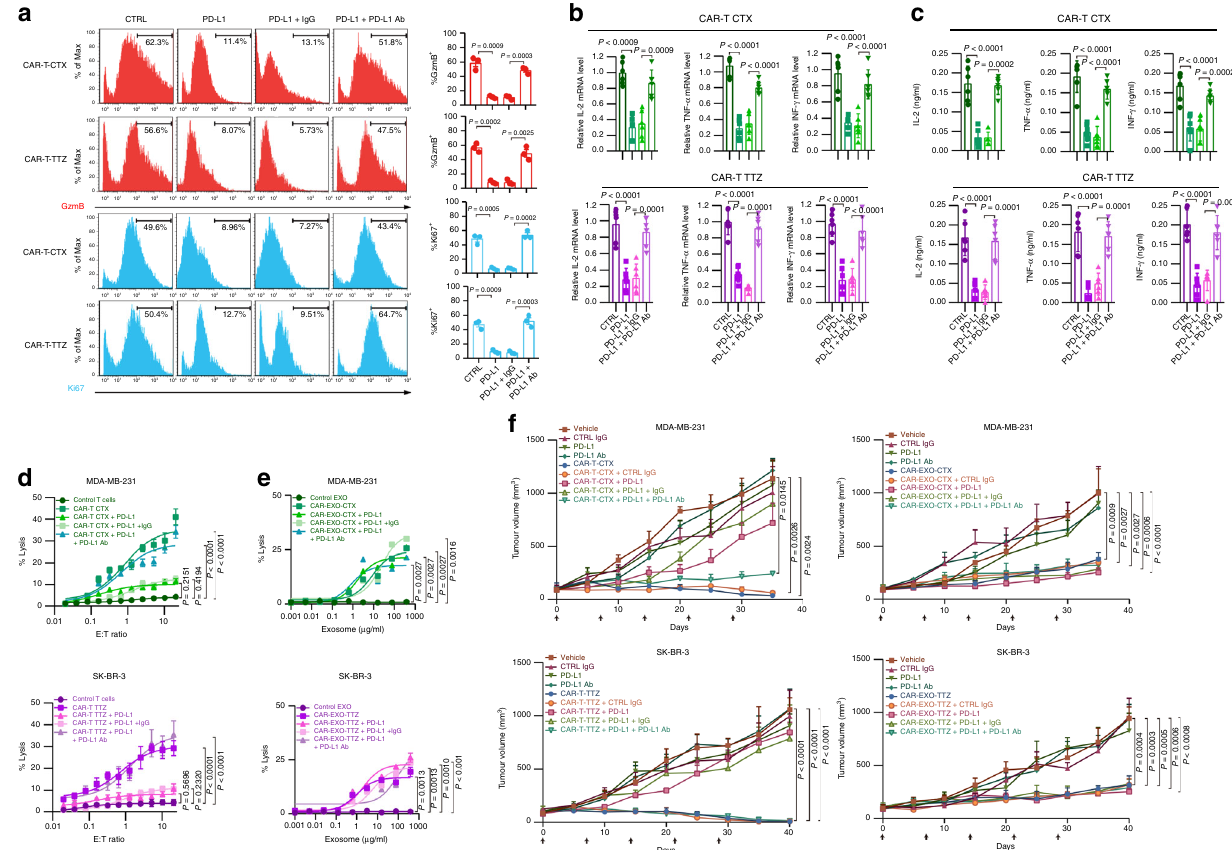
Fig. 6 PD-L1 inhibits CAR-T cells but not CAR exosomes in vitro and in vivo. a Representative histogram of the expression of granzyme B (GzmB, red) and Ki-67 (blue) after the indicated treatments in CAR-T cells. The proportions of cells with positive GzmB or Ki-67 expression are shown on the right. b qPCR analyses of IL-2, IFN- γ , and TNF in CAR-T cells after the indicated treatments with or without blocking by recombinant PD-L1 or the anti-PD-L1 antibodies. The relative mRNA expression level was calculated as the ratio to the control cells. c ELISA of IL-2, IFN- γ , and TNF in CAR-T cells after the indicated treatment with or without blocking by recombinant PD-L1 or the anti-PD-L1 antibodies. d , e Killing activity of CAR-T cells ( d ) and CAR exosomes ( e ) in response to tumour cells. The cytotoxic activity of CAR-T or CAR exosomes against cancer cell lines was assessed by the 51 Cr-release assay at the indicated effector-to-target (E:T) ratios or indicated concentrations with or without blocking by recombinant PD-L1 or anti-PD-L1 antibodies. f Tumour volumes of MDA-MB-231 (up) and SK-BR-3 (down) tumour xenografts after the indicated treatment (left, CAR-T cells; right CAR exosomes). n = 8. Arrows indicate the treatment point ( f ). Data are mean ± s.d. ( a – e ) of three ( a ) or six ( b – e ) independent biological replicates or means ± s.e.m. ( e ). P values are from a two-sided unpaired t test ( a – c ) or a two-way ANOVA followed by the Bonferroni post-test ( d – f ); Source data ( a – f ) are provided as a Source Data fi